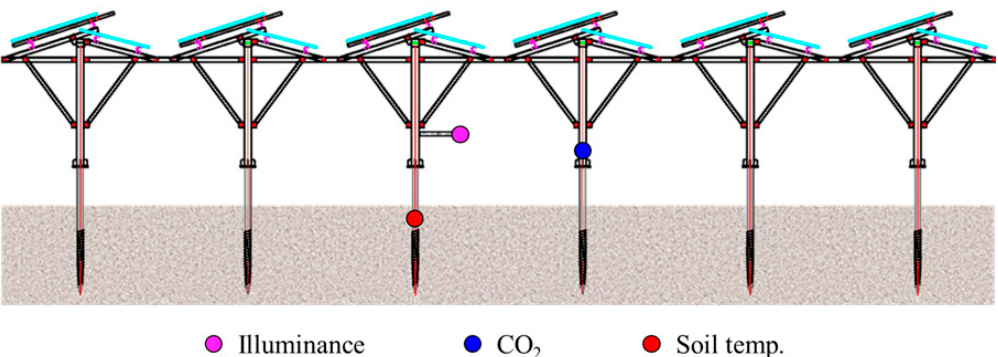
Figure 8. Data-collection process.